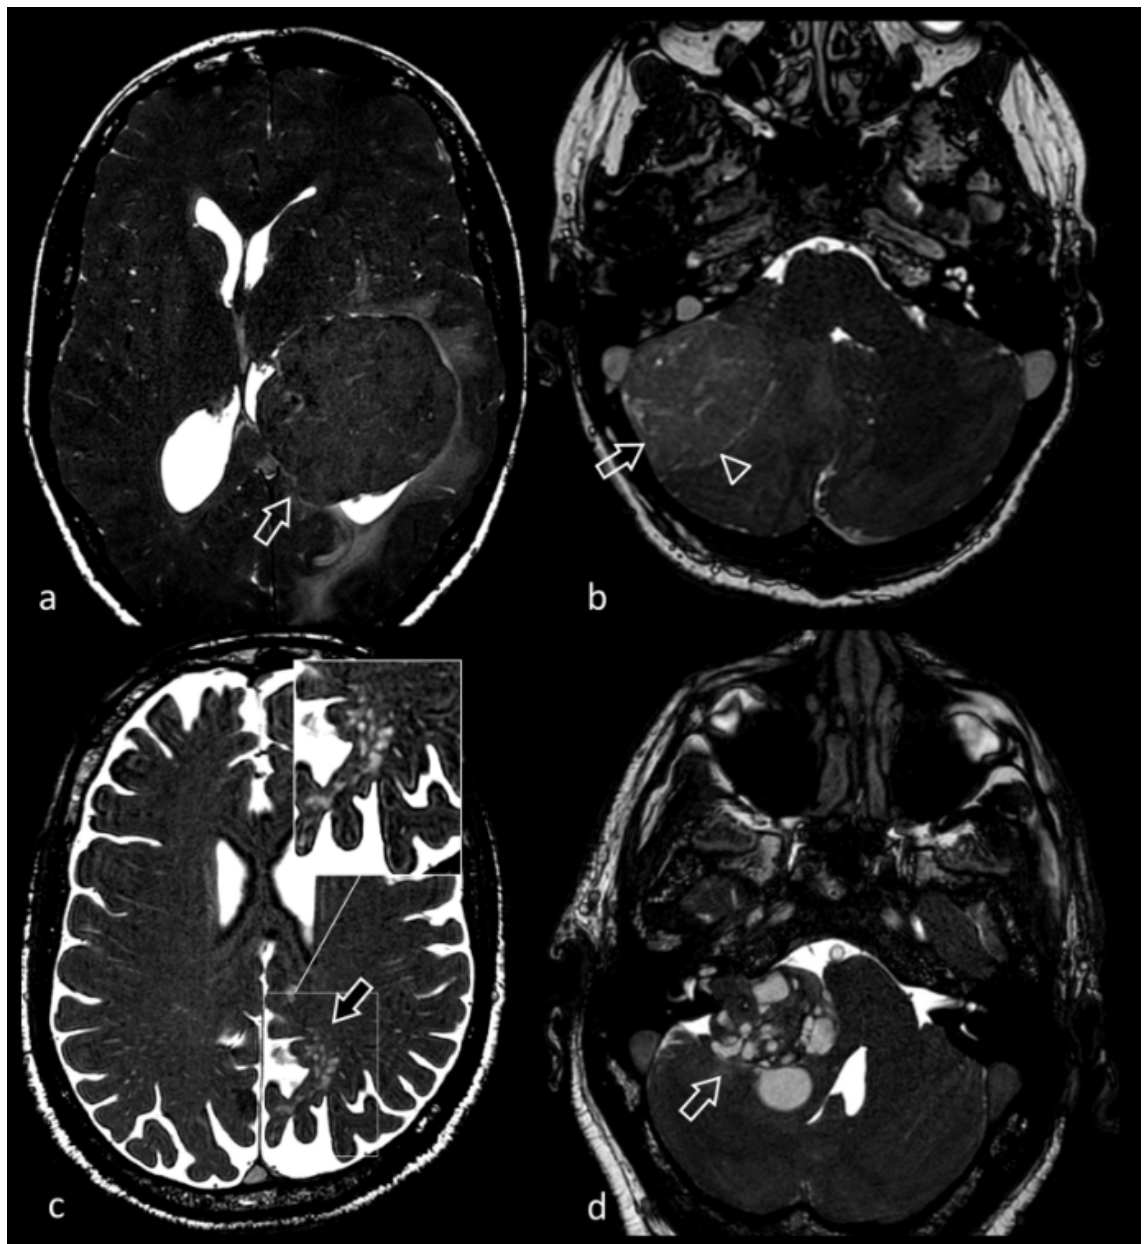
Figure 10. ( a ) Axial 3D CISS image shows a large mass (arrow) in the left lateral ventricle. 3D CISS accurately depicts the endoventricular location of the mass and helps characterize its relationship with the surrounding brain tissue. Histological findings were in keeping with intraventricular fi- brous meningioma. ( b ) 32-year-old female patient with a large lesion (arrow) in the posterior fossa,